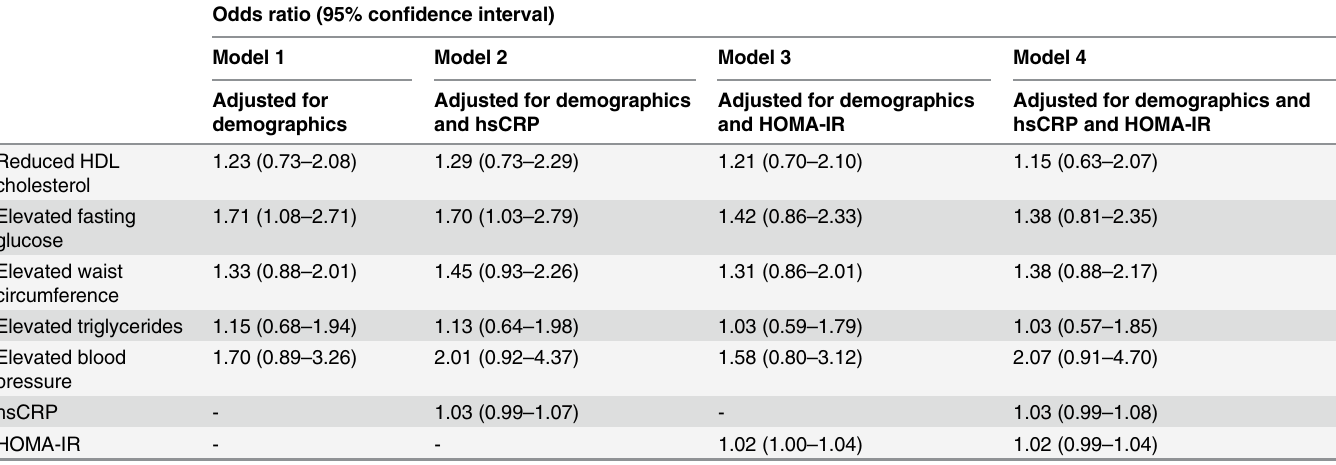
Table 5. Odds ratios for chronic kidney disease predicted by individual components of the metabolic syndrome with adjustments as described